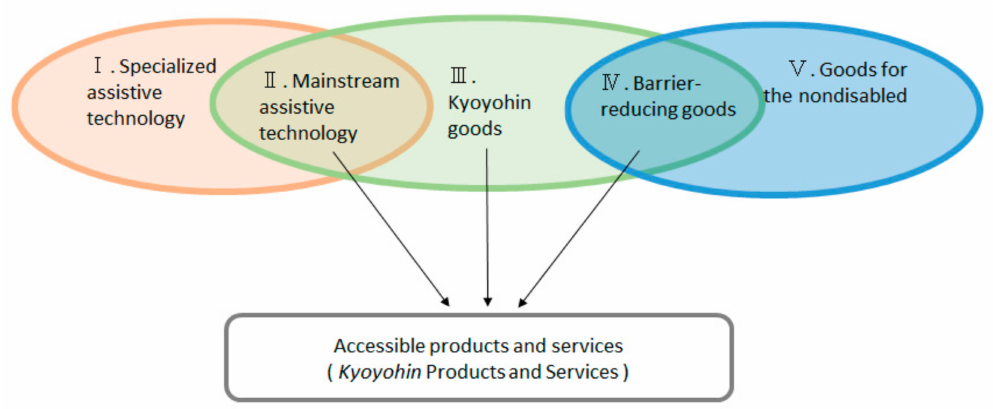
Figure 1. Concept of Kyoyohin products and services (Source: Accessible Design Foundation of Japan (ADF Japan) [14]; What is Accessible